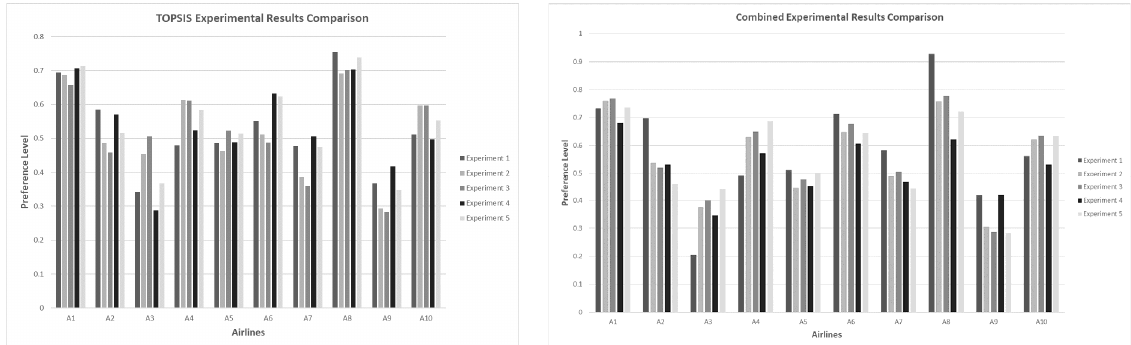
Fig. 2. TOPSIS experimental results Fig. 3. Hybrid experimental